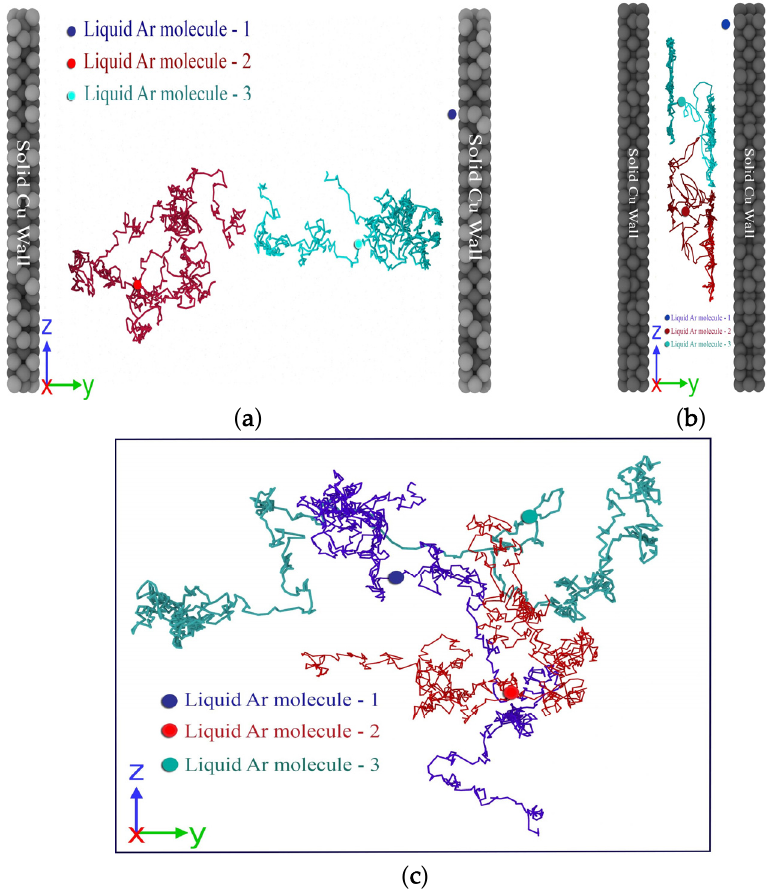
Figure 5. Trajectory of molecules’ displacement (T = 100 K) at a predefined time interval (Frame interval 0 to 1000) (a) Nanogap confined liquid with h/a = 12.5 i.e., h = 7.3 nm. (b) Nanogap confined liquid with h/a = 3.0 i.e., h = 1.8 nm. (c) Bulk liquid.